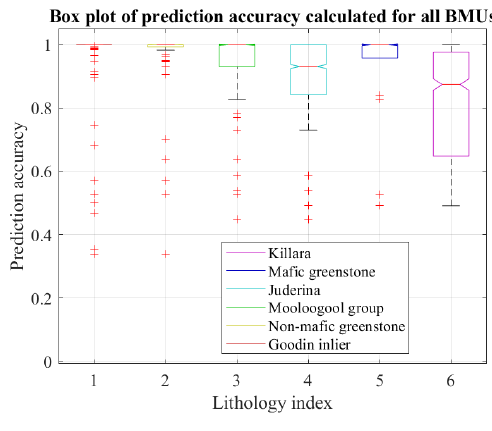
Figure B1. Box plot of prediction accuracies for the different lithologies. Red crosses mark